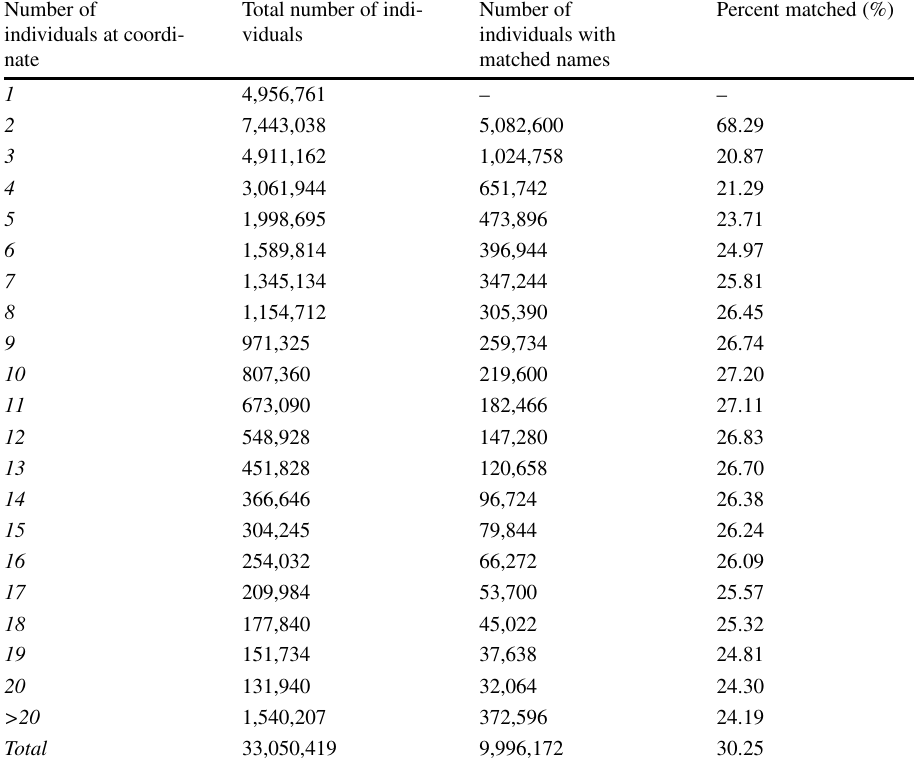
Total number of indi- viduals